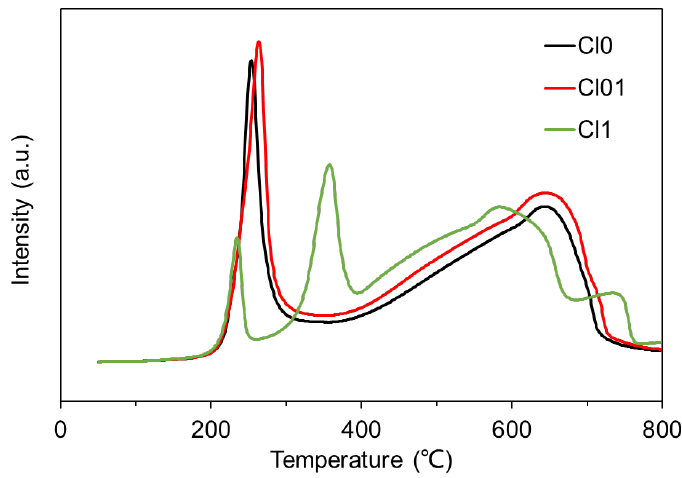
Figure 6. H 2 -TPR profiles of Cl0, Cl01, and Cl1